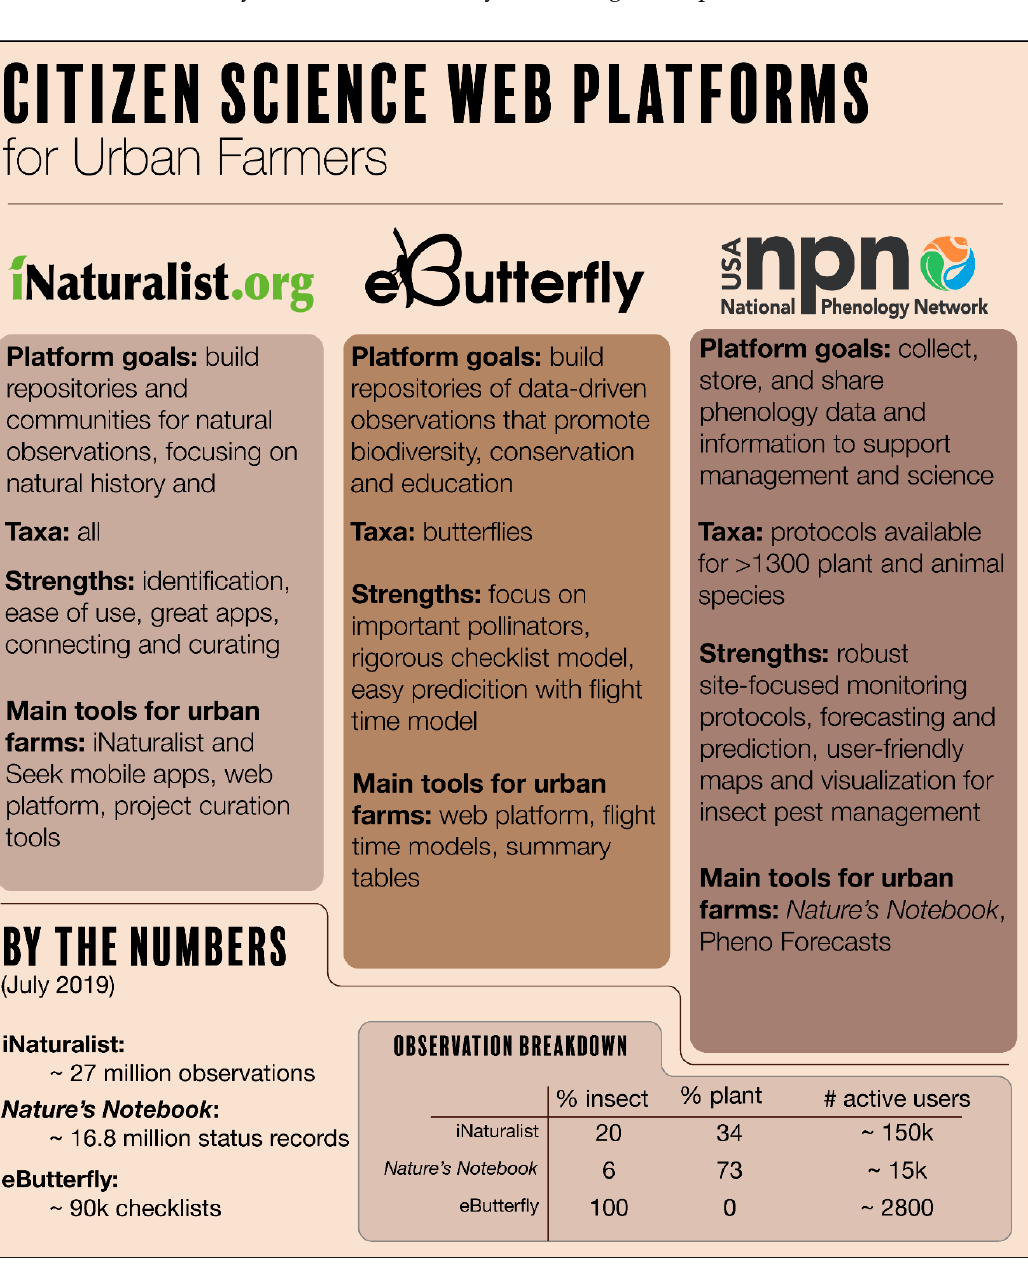
Figure 1. Comparison of iNaturalist, eButterfly, and USA National Phenology Network. Three citizen science platforms o ff er growers various tools, data, information, and social networks to improve the management of their farm insects, including beneficials, pests, and pollinators.